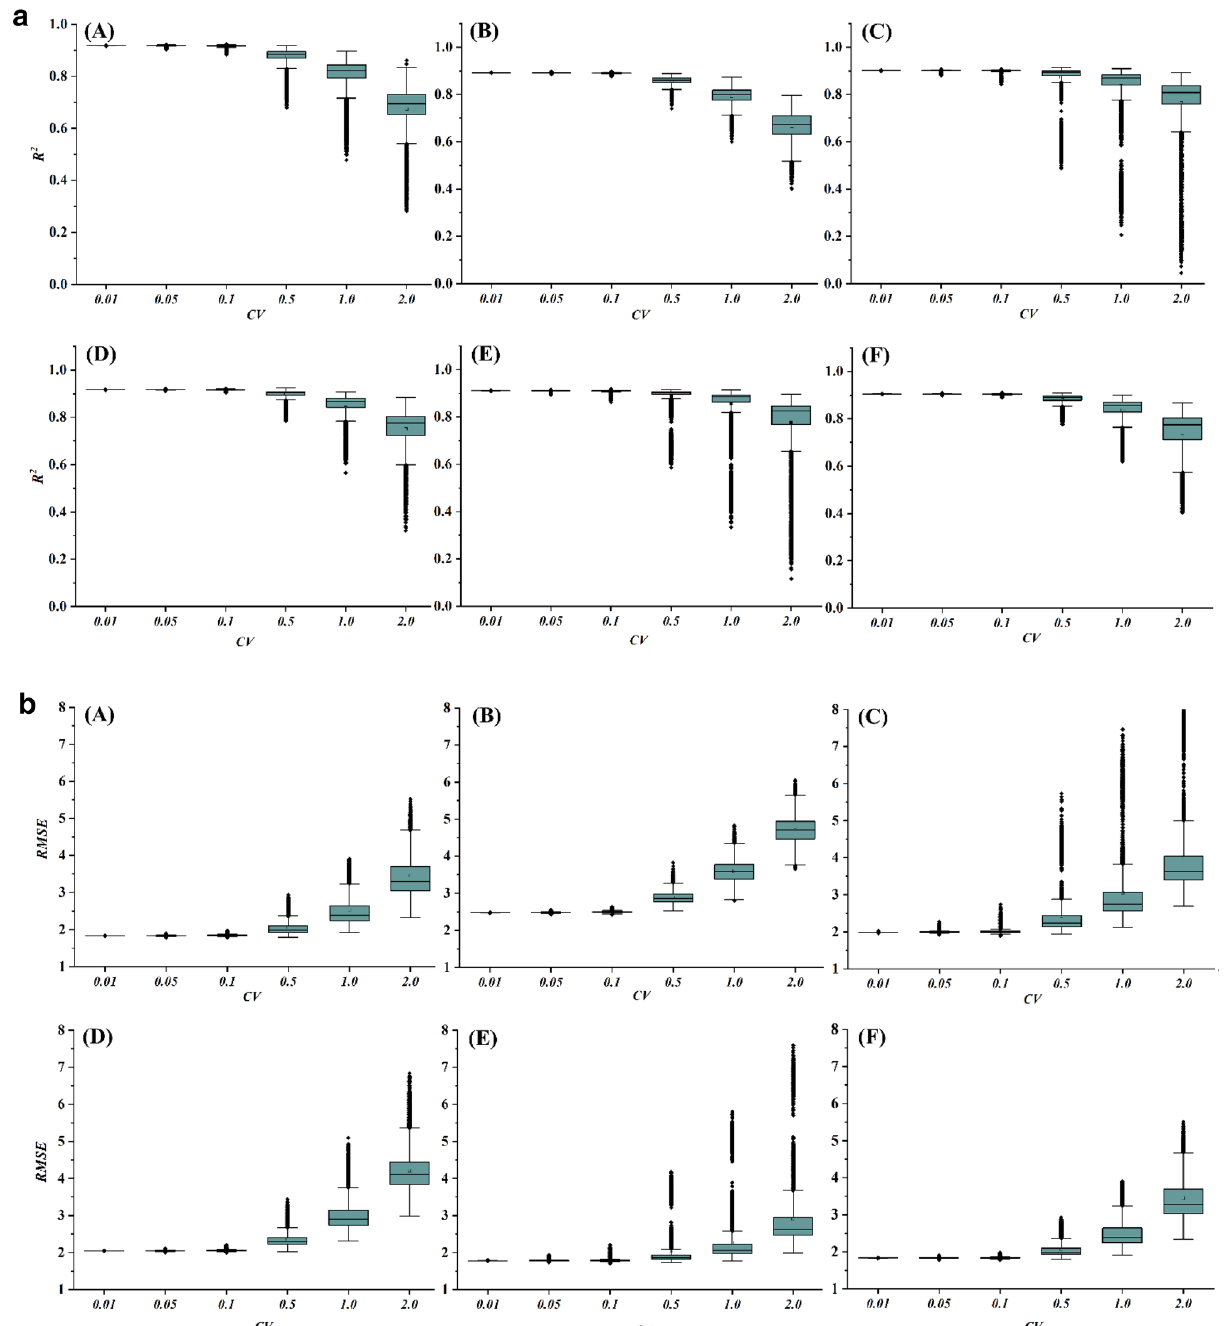
Figure 7. ( a ) Variation of R 2 values when two stations have random data with different CV : A = Sylhet, B = Srimangal, C = Rangpur, D = Mymensingh, E = Dinajpur and F = Bogra. ( b ) Variation of RMSE values when two stations have random data with different CV : A = Sylhet, B = Srimangal, C = Rangpur, D = Mymensingh, E = Dinajpur and F =